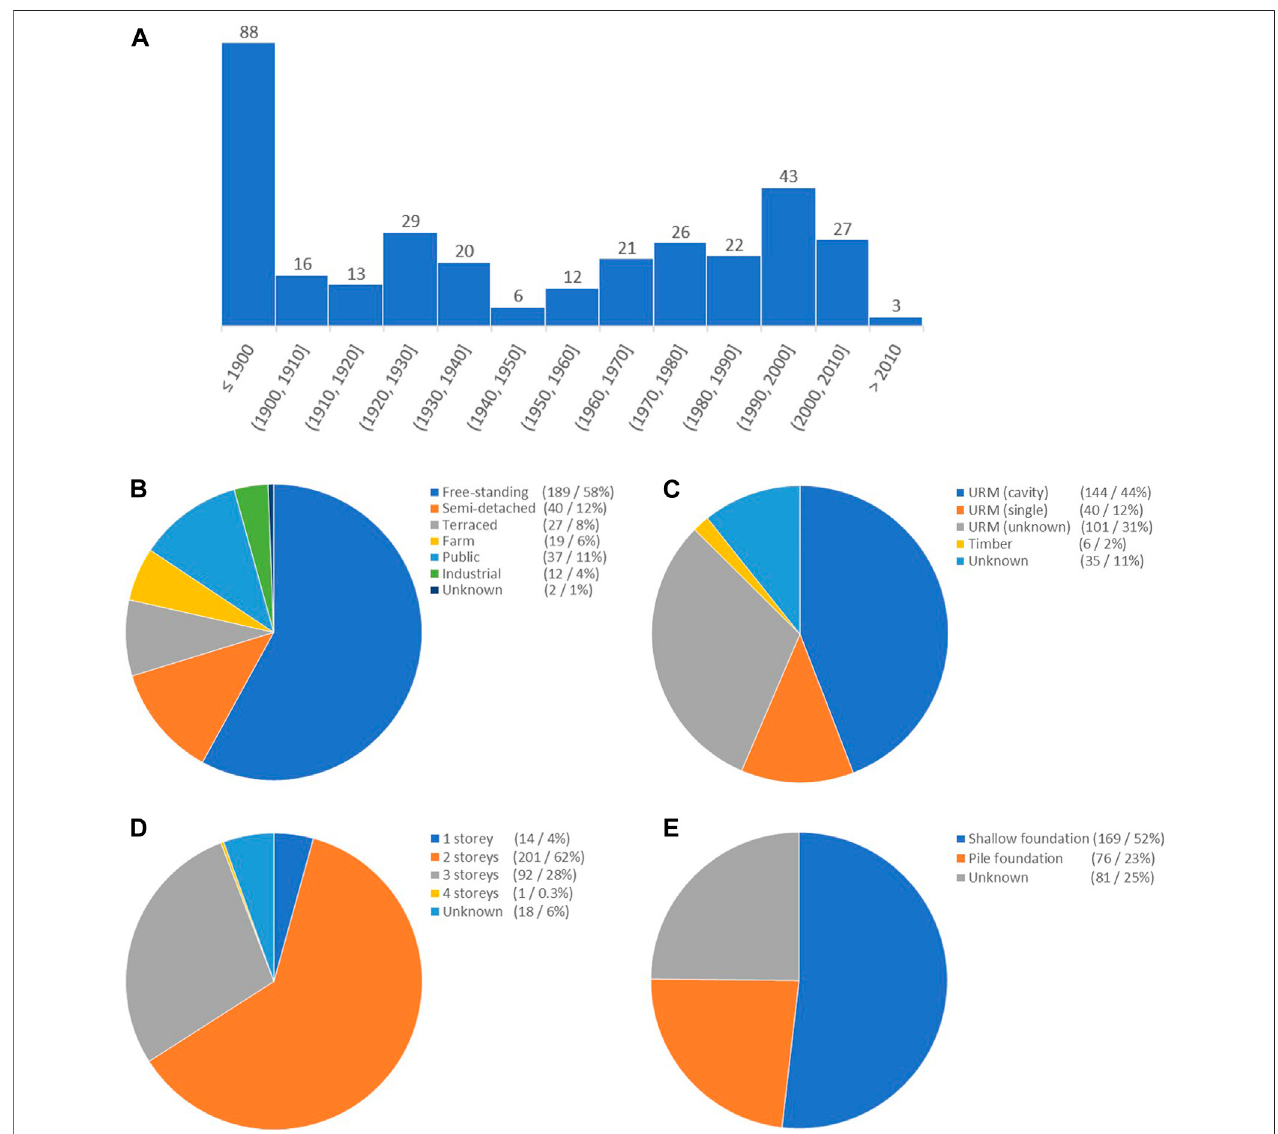
FIGURE 2 | Characteristics of the buildings in the Groningen monitoring network: (A) construction year, (B) building type, (C) construction material, (D) number of stories, (E) foundation type.